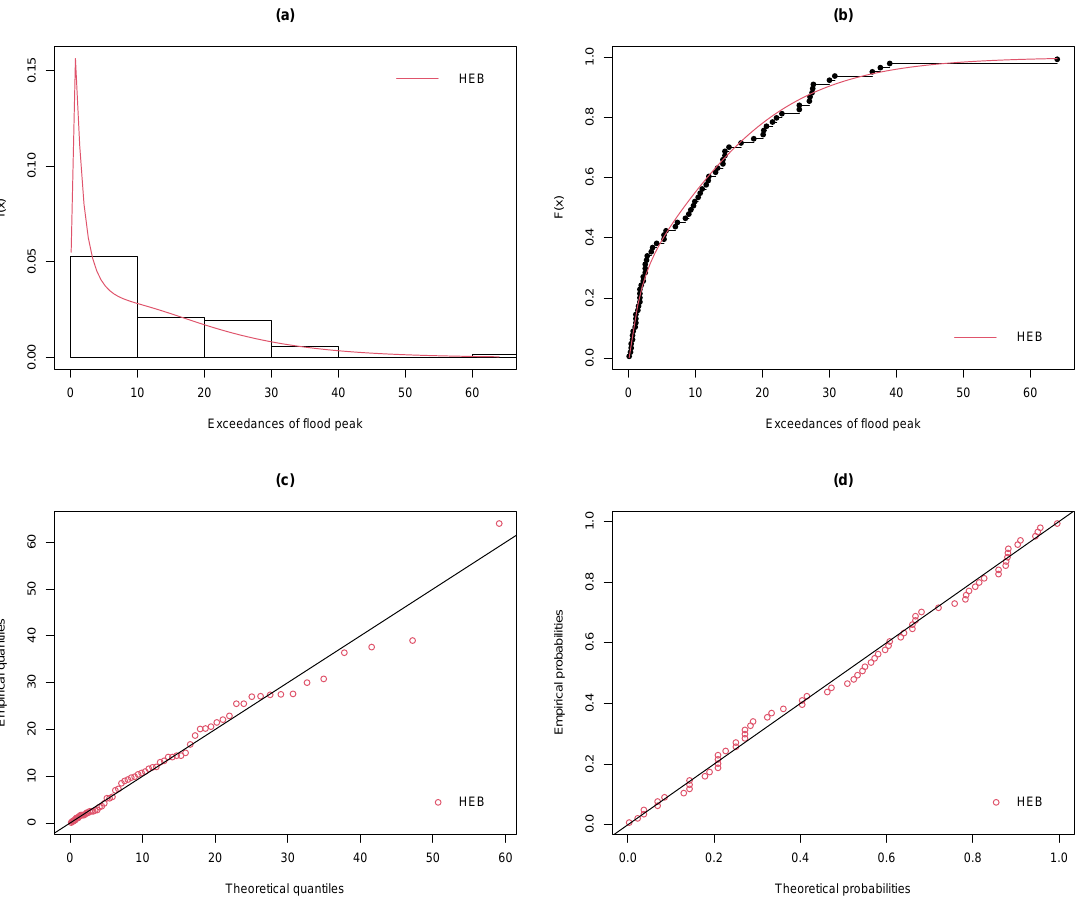
Figure 4. The fitted pdf ( a ), cdf ( b ), Q-Q plot ( c ), and P-P plot ( d ) of the HEB model for the Wheaton river